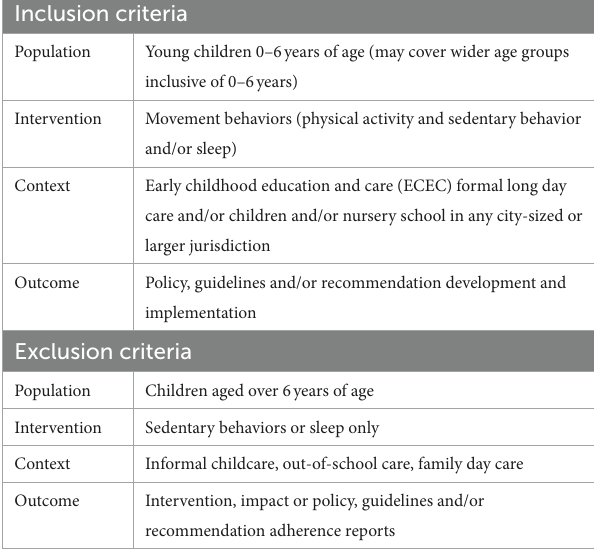
TABLE 1 Scoping review inclusion and exclusion